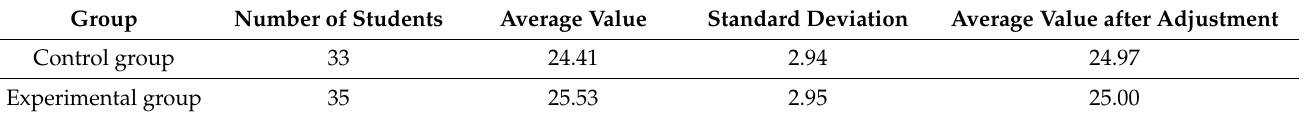
Table 14. Recapitulation sheet of statistics in overall learning effectiveness of basic electricity practical -knowledge component.